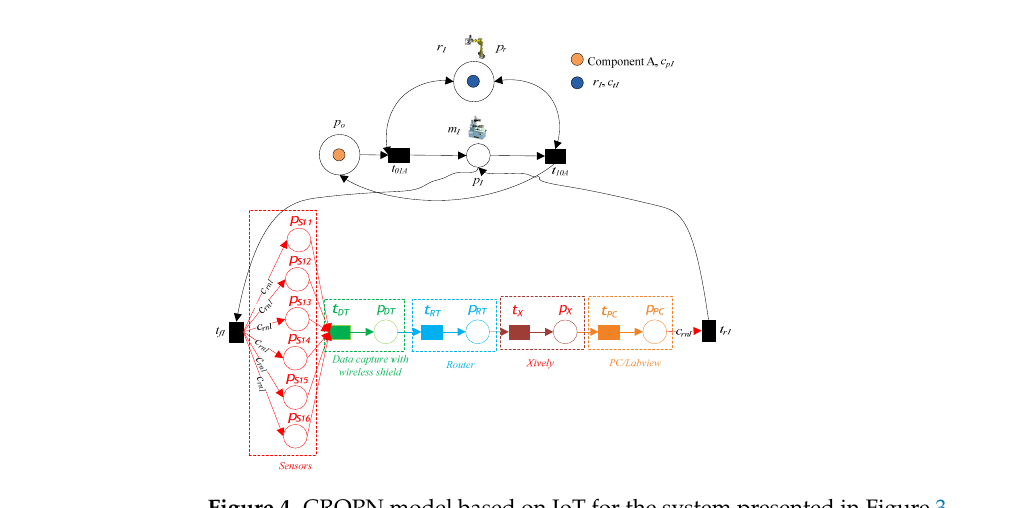
Figure 4. CROPN model based on IoT for the system presented in Figure 3.